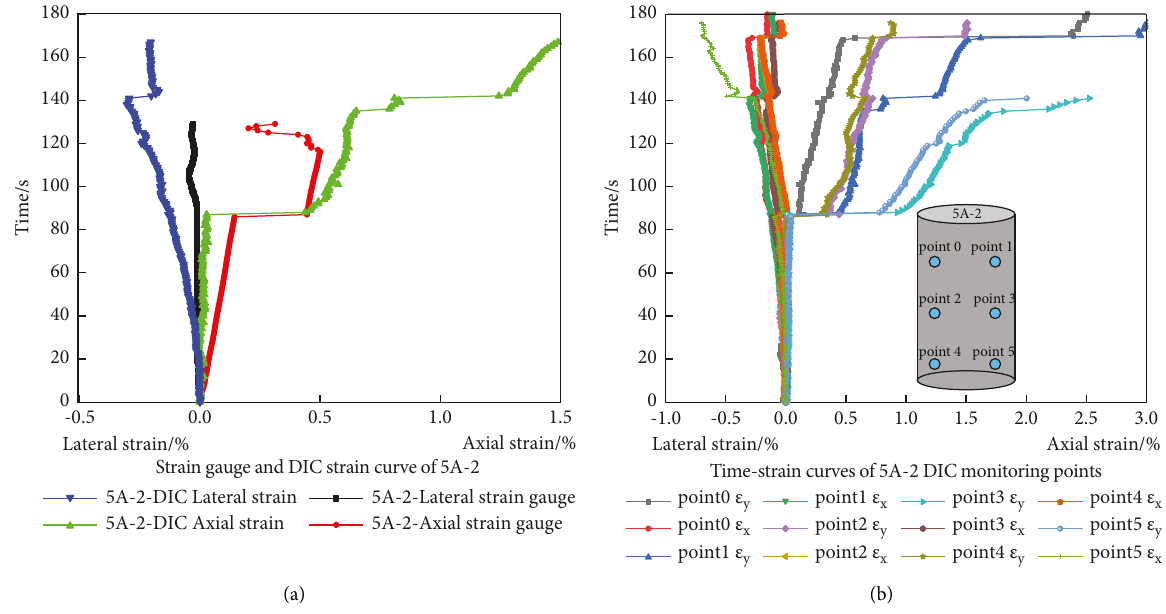
Figure 11: Time-strain curve of 5A-2. (a) Strain gauge and DIC strain curve of 5A-2. (b) Time-strain curves of 5A-2 DIC monitoring points.